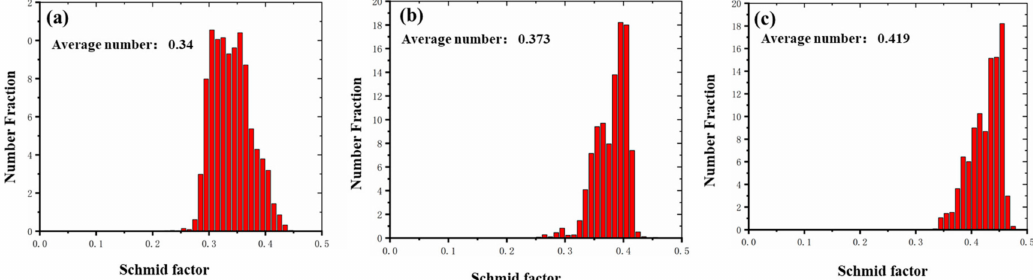
Figure 6. The magnitude of the Schmid factors of the various sliding systems for the as-MAFed pure Mg, deformed up to a strain of 0.20: ( a ) The basal < a > sliding system ({0001} < 11–20 > ; ( b ) the pyramidal < c + a > sliding system {10–11} < 11–20 > ; and ( c ) the pyramidal < c + a > sliding system {11–22} < 11–23 >